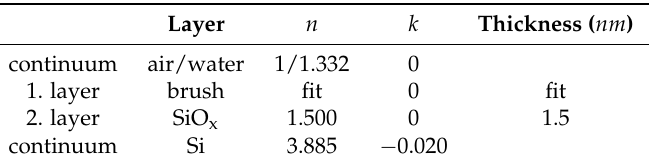
Table 1. Two-layer-model for fitting polymer brushes on a silicon wafer against air or water. Parameters are refractive index n , absorption coefficient k and the thickness of the layer, respectively. Empty arrays imply bulk properties with an infinity thickness and